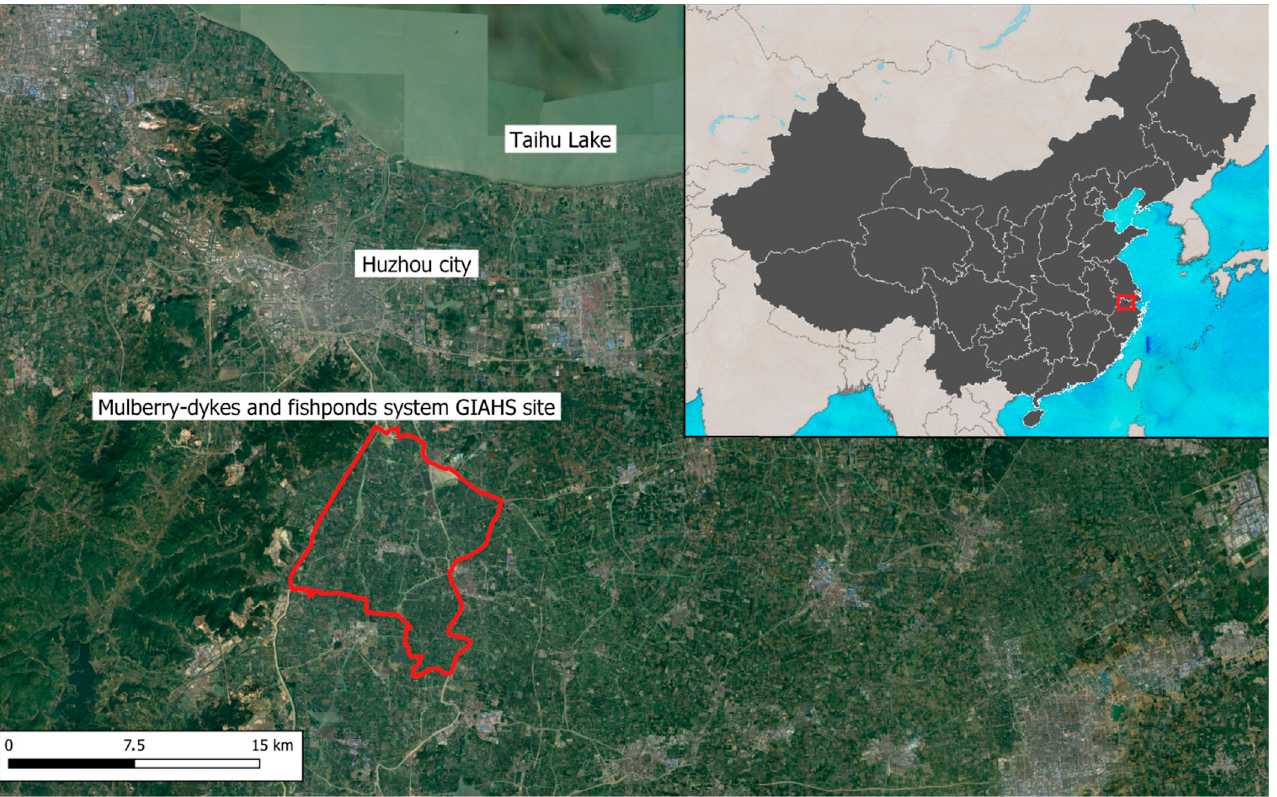
Figure 1. The mulberry-dykes and fishponds agroforestry system GIAHS site is located immediately south of Hozhou city, near Taihu Lake, in Eastern China.